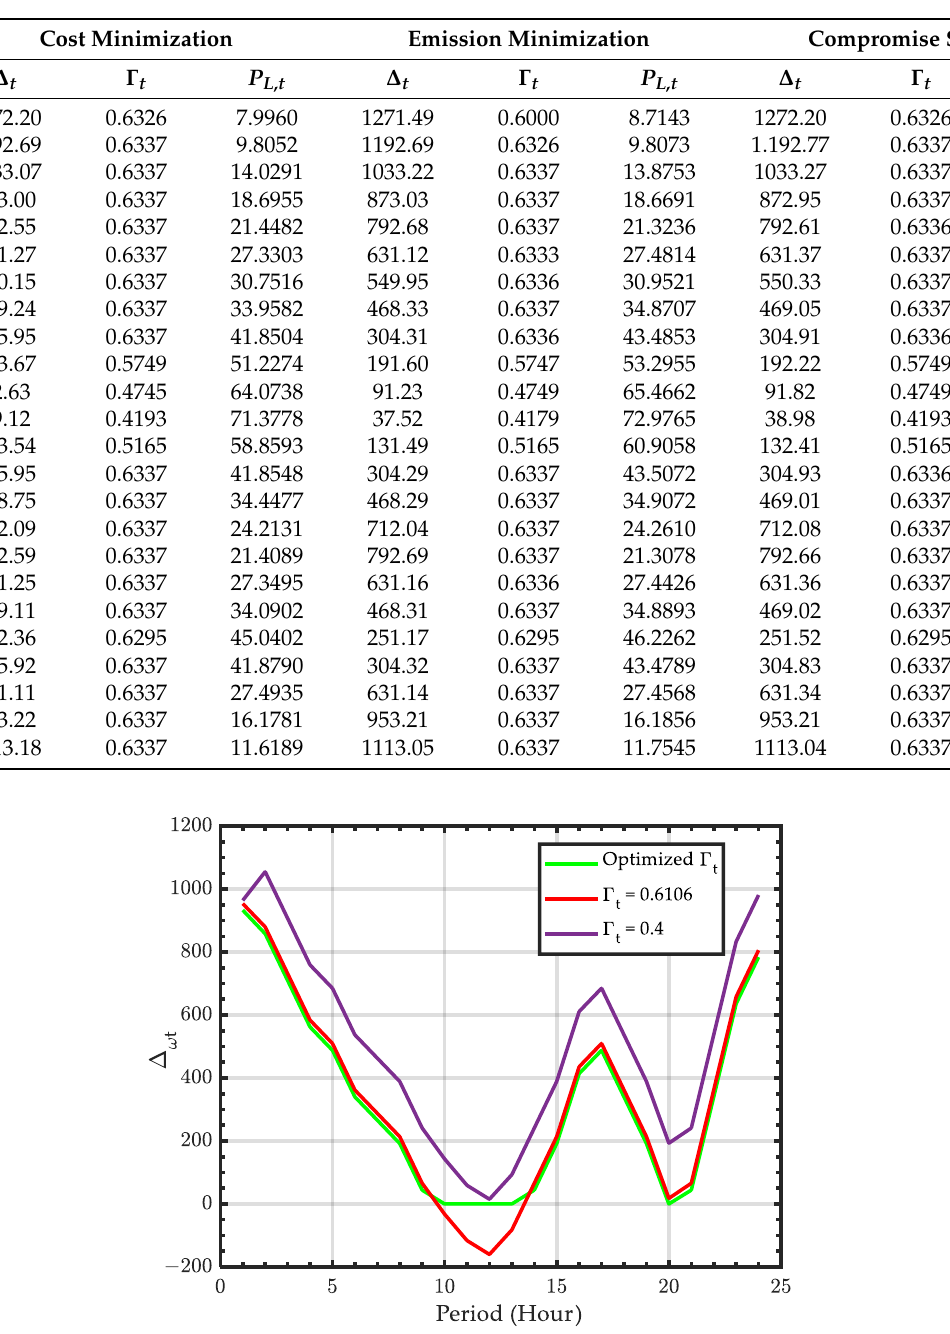
 . Figure 9. Hourly variation of ∆ wt wt